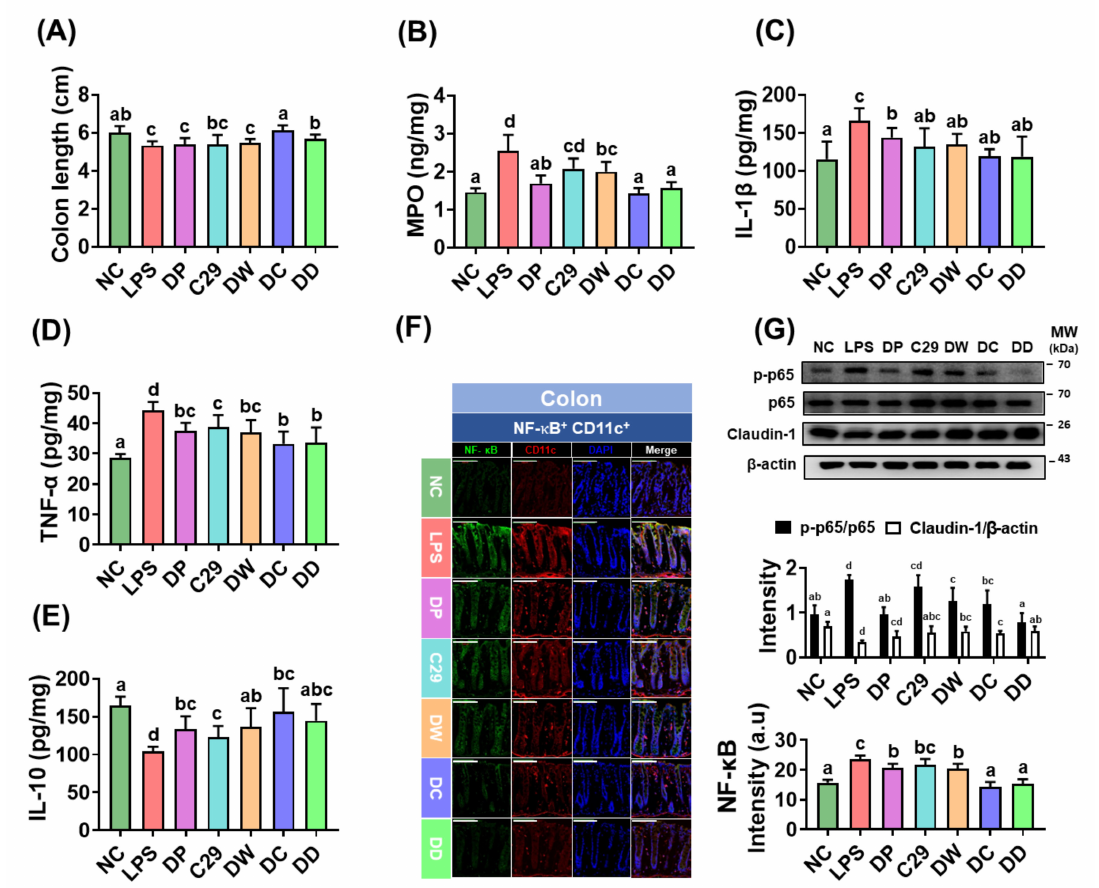
Figure 3. The combined treatment of donepezil with C29 or DW2009 alleviated colitis in mice with LPS-induced cognitive impairment. Effects on colon length ( A ); myeloperoxidase (MPO) activity ( B ), and IL-1 β ( C ); TNF- α ( D ), and IL-10 expression ( E ) in the colon. Effects on NF- κ B+/CD11c+ cell population ( F ) and NF- κ B activation and claudin-1 expression ( G ). LPS was intraperitoneally injected in mice once a day for 5 days. NC was treated with saline instead of LPS. Test agents (NC, vehicle [saline] alone; LPS, vehicle; DP, 1.5 mg/kg/day of donepezil; C29, 1 × 10 9 CFU/mouse/day of C29; DW, 100 mg/kg/day of DW2009; DC, 1.5 × 10 9 CFU/mouse/day of C29 plus 1.5 mg/kg/day of donepezil; and DD, 100 mg/kg/day of DW2009 plus 1.5 mg/kg/day of donepezil) were orally gavaged in mice daily for 5 days. The confocal microscopy images of a single plane ( F ) were quantified by ImageJ software. Magnification scale bars are 100 µ m. Data values are as mean ± SD ( n = 7). Means with the same letters are not significantly different ( p <